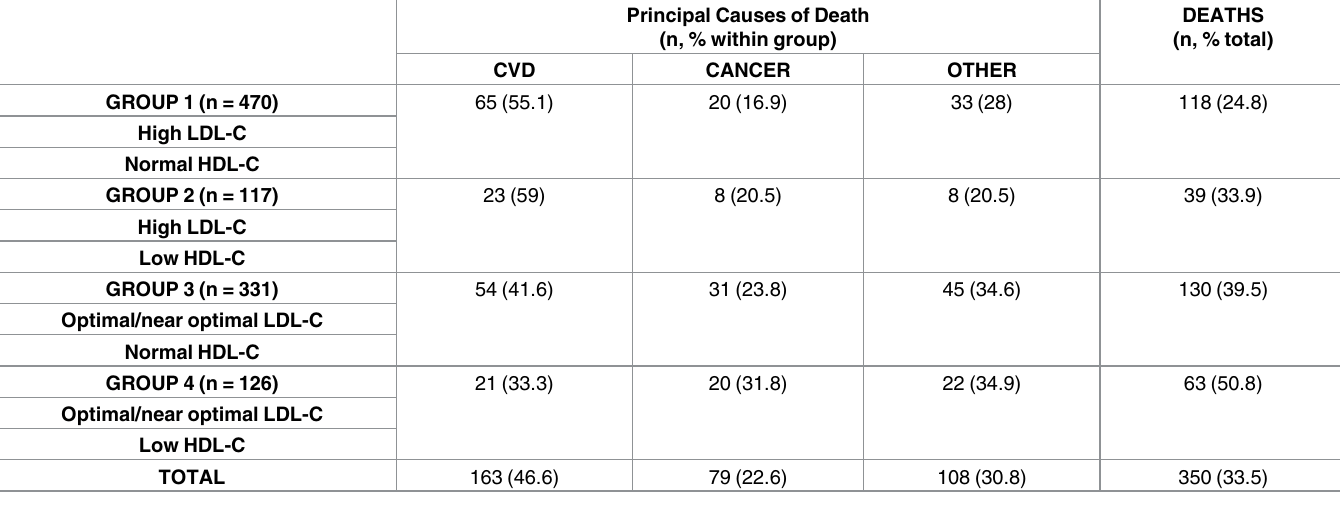
Table 2. Principal causesof death after 9 year follow-up period in 1044 community dwelling older individuals enrolled into the INCHIANTI study, according to combined levels of LDL-C and HDL-C.